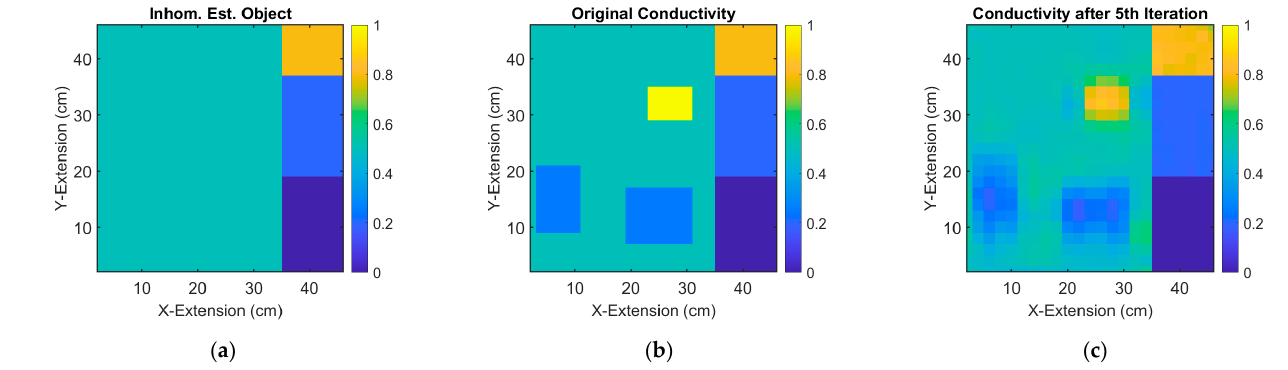
Figure 12. Conductivity reconstruction of a 2D, weakly conductive, and inhomogeneous object 46 cm × 46 cm: ( a ) Previously estimated object with pronounced inhomogeneities on the right side (prior knowledge for differential MIT). ( b ) Actual object with additional and unknown deviations. ( c ) 2D reconstruction. The previously suspected features are only confirmed by the MIT measurement, but no need to be lossy reconstructed. On the other hand, the unexpected deviations are revealed with the losses typical for MIT.